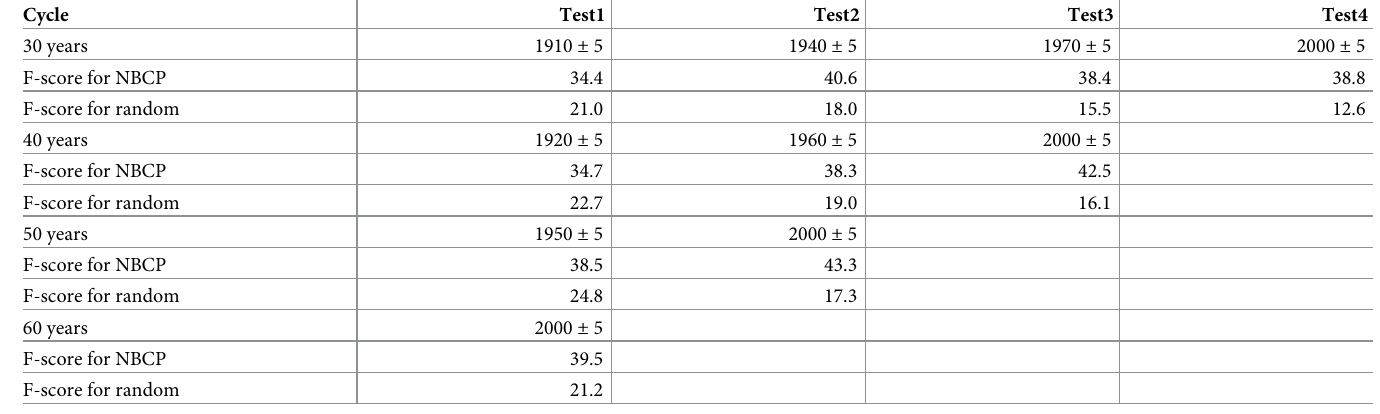
Table 9. The effect that varying cycle lengths has on the F-score of NBCP and random guessing. Cycle Test1 Test2 Test3 Test4 30 years F-score for NBCP F-score for random 40 years F-score for NBCP F-score for random 50 years F-score for NBCP F-score for random 60 years F-score for NBCP F-score for